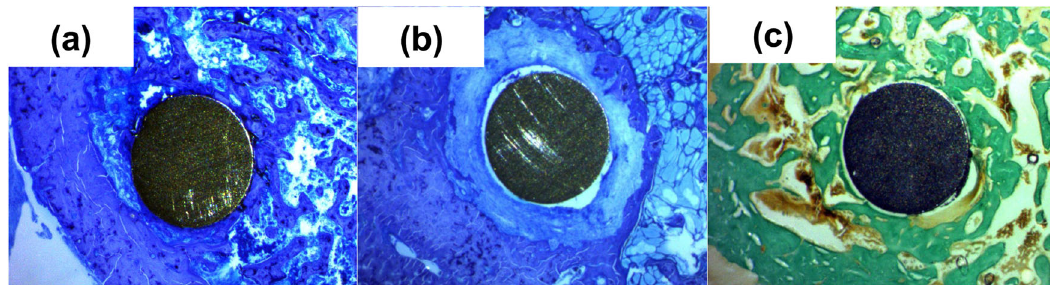
Fig. 3 Histology of femurs after 30 days of implantation for: a Ti6Al4V as received alloy, b Ti6Al4V 800 , and c Ti6Al4V